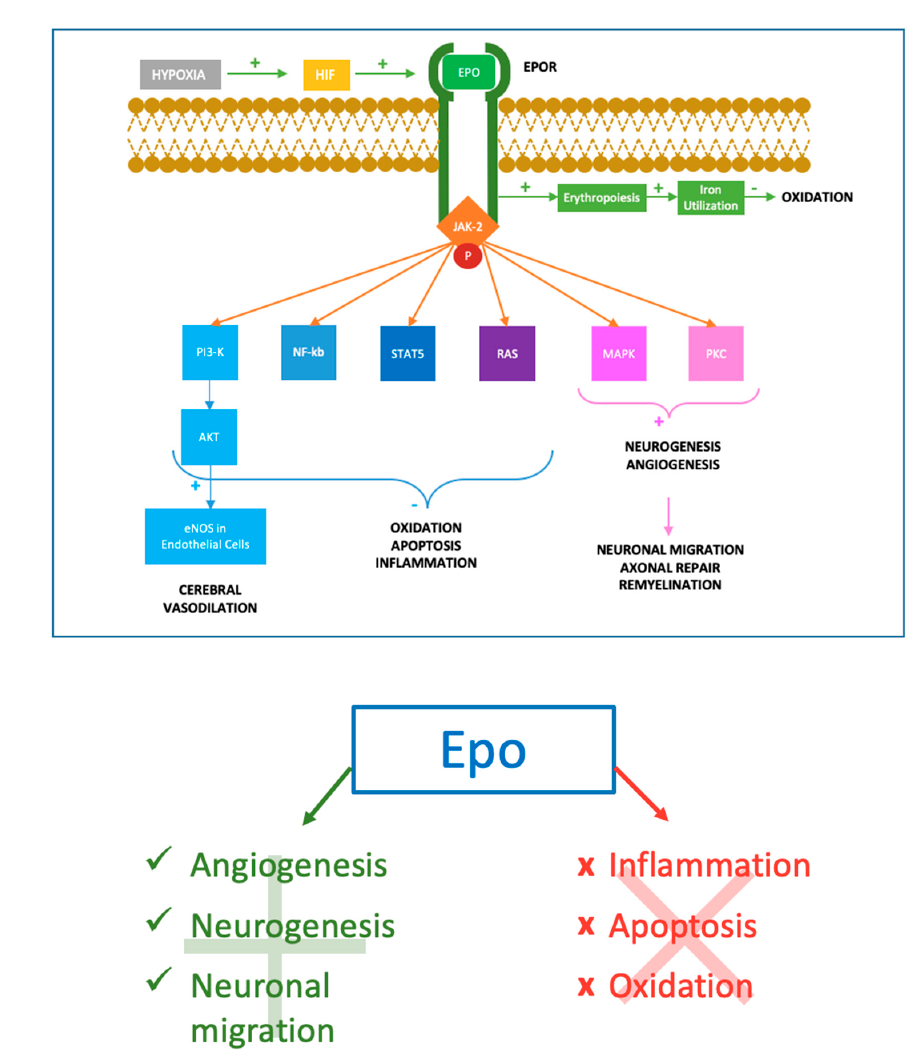
Figure 2. Molecular mechanisms of Epo action. ( A ) After hypoxia, the production of HIF determines an augmented synthesis of Epo which binds to its transmembrane receptor EpoR. The cytoplasmic tail of the Epo-EpoR complex phosphorylates JAK2, which activates a complex cascade of signalling pathways. The activation of PI3K/AKT pathway leads to the increase of eNOS activity in endothelial cells, determining augmented levels of NO and cerebral vasodilation. PI3K/AKT, together with NF-kb, STAT-5 and RAS pathways, reduces inflammation, oxidation and apoptosis acting both at nuclear and intramitochondrial levels. Moreover, MAPK and PKC mediated mechanisms promote neurogenesis and angiogenesis in damaged tissues. Neurogenesis, especially oligodendrogenesis, facilitates the process of remyelination and axonal repair, while angiogenesis permits flow restoration and migration of neuronal progenitors in the ischemic areas. The erythropoietic effect of Epo-EpoR binding is an additional antioxidant mechanism, increasing iron utilization resulting in a lower iron oxidant potential. JAK-2: Janus-tyrosine-kinase-2; PI3K: phosphoinositide 3-kinase; AKT: v-akt murine thymoma viral oncogene homolog; eNOS: endothelial nitric oxide synthase; NO: nitric oxide; NF-kb: nuclear factor kappa-light-chain-enhancer of activated B cells; STAT-5: signal transducer and activator of transcription 5; RAS: rat sarcoma; MAPK: mitogen-activated protein kinase; PKC: protein kinase C. ( B ) Mechanisms promoted and inhibited following Epo treatment. Epo has shown anti-apoptotic [73–75], antioxidant [76–78] and anti-inflammatory properties [79–83]. Epo promotes angiogenesis [74,86,87], oligodendrogenesis, neuronal progenitors migration in the ischemic areas (Wang et al., 2004; Ohab et al., 2006; Li et al., 2007) and neurogenesis